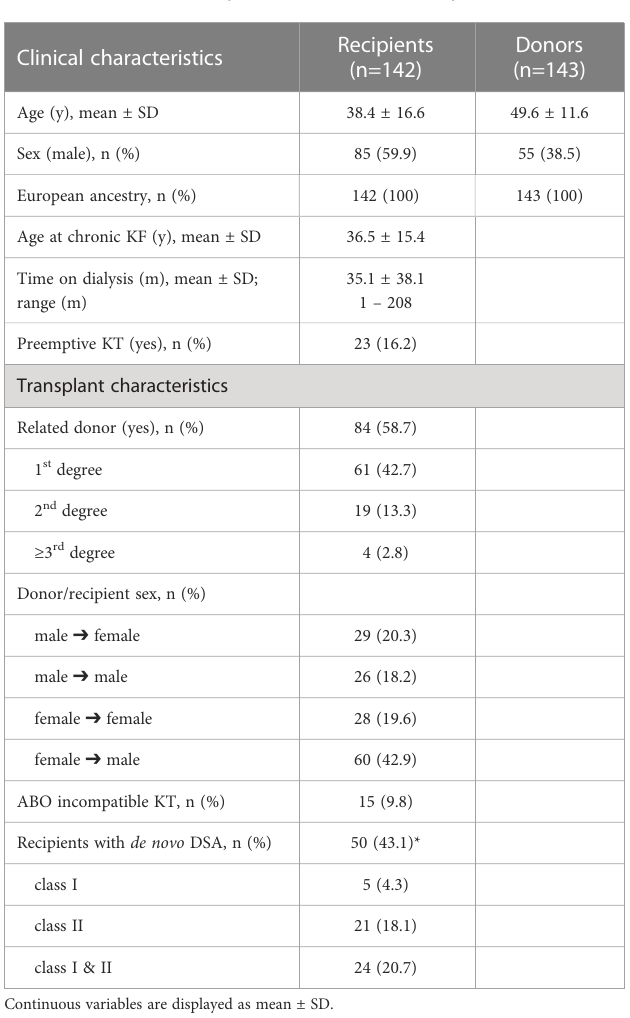
TABLE 1 Clinical and transplant characteristics of recipients and donors.